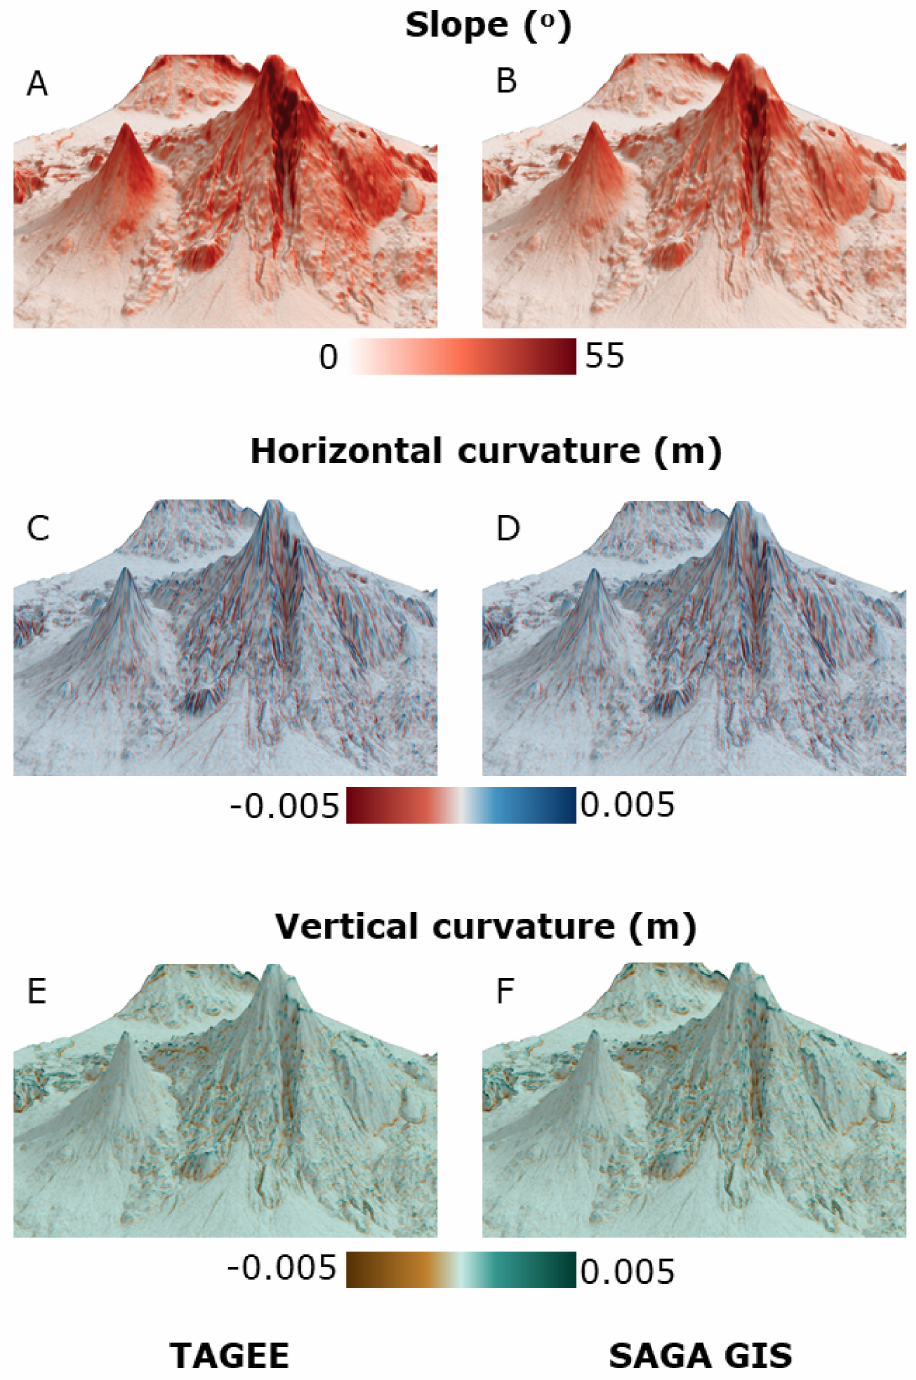
Figure 4. 3D visualizations of terrain attributes produced near Mount Ararat: slope, horizontal and vertical curvature from TAGEE ( A , C , E , respectively) and SAGA GIS ( B , D , F , respectively). 3D maps are displayed with a vertical exaggeration of